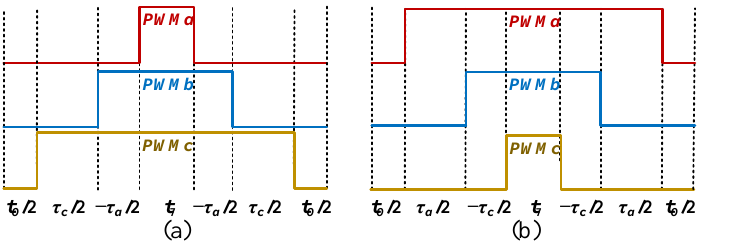
Figure 5. The PWM signals when τ b 1 = 0. ( a ) The PWM signal with the vectors − V a and V c . ( b ) The PWM signal with the vectors V a and − V c